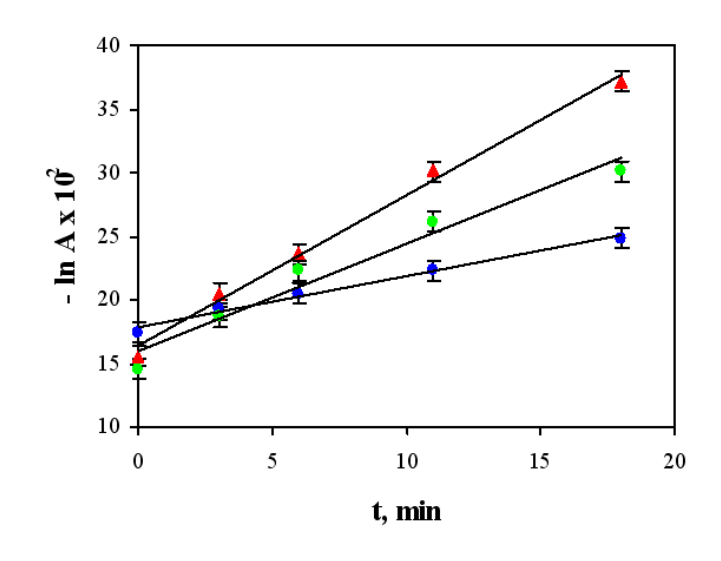
Fig. 3 The negative logarithm of absorbance as a function of time for 3-CPBA decomposition in acetonitrile by catalase-based biocatalysts: CAT/TiS (blue circles; R= 0.996); CAT/NORIT (red triangles; R= 0.997) and CAT/PM-100 (green circles; R= 0.981); temperature 25 ◦ C, substrate initial concentration ∼ 90 µ M. R denotes the linear regression coefficient for each